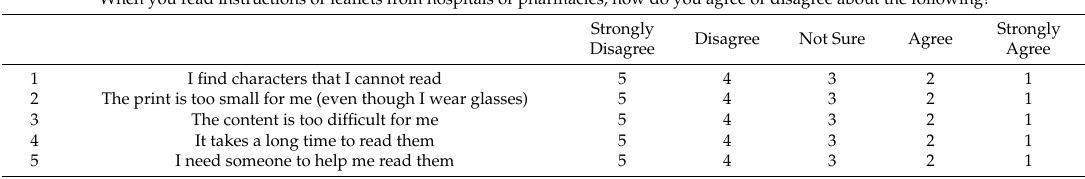
Table 1. The 14-item Health Literacy